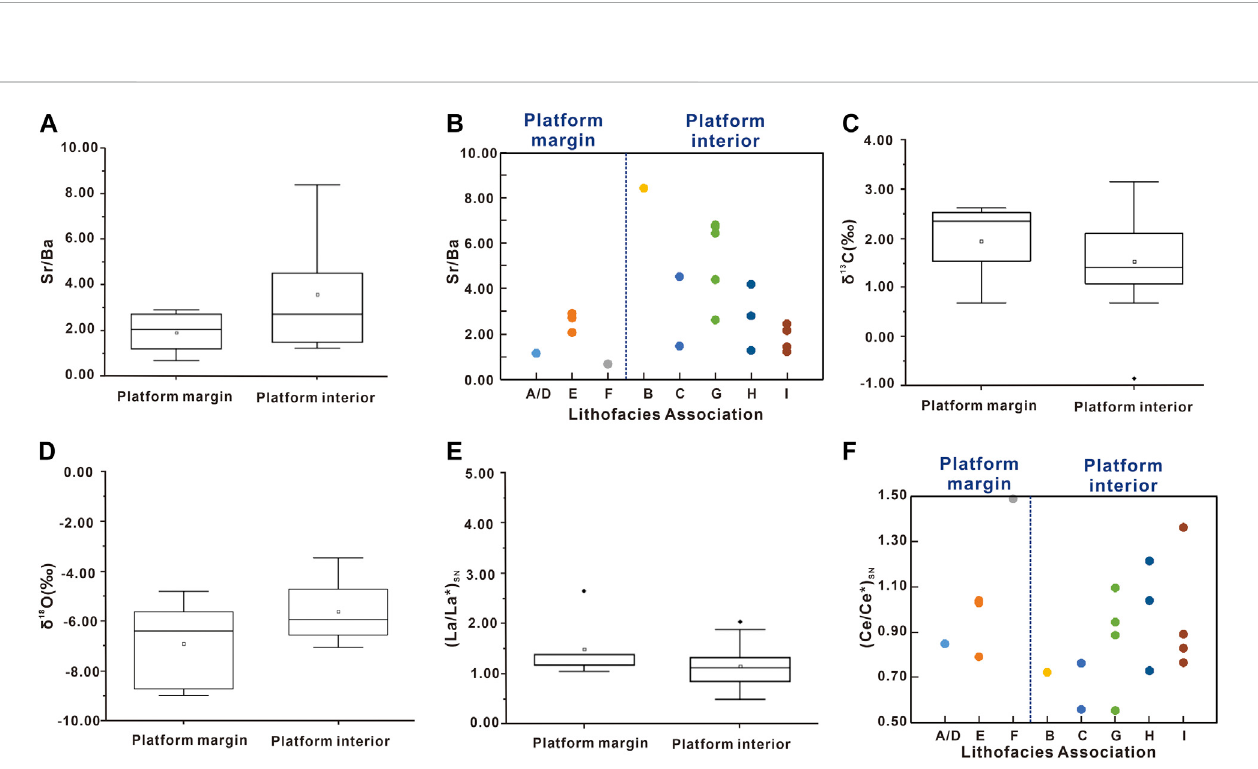
FIGURE 11 Salinity and redox related geochemical proxies characteristics of different microbialite lithofacies associations. (A) Box plot of the Sr/Ba ratios of microbialite lithofacies associations in platform margin and platform interior. (B) Sr/Ba ratios of individual microbialite lithofacies association. (C) Box plot of δ 13 Cvaluesofmicrobialitelithofaciesassociationsinplatformmarginandplatforminterior. (D) Boxplotof δ 18 Ovaluesofmicrobialitelithofaciesassociationsin platformmarginandplatforminterior. (E) (La/La*) SN valuesofmicrobialitelithofaciesassociationsinplatformmarginandplatforminterior. (F) (Ce/Ce*) SN values of individual microbialite lithofacies